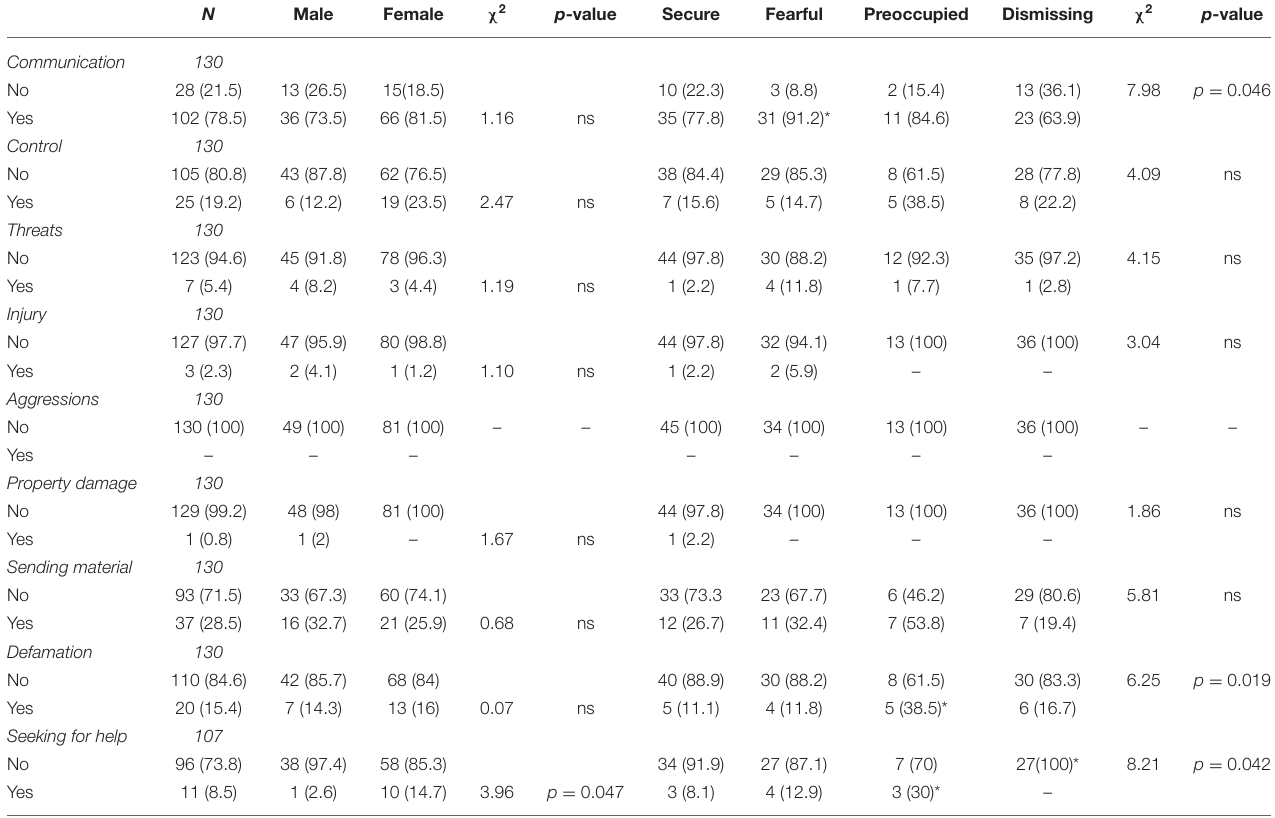
TABLE 3 | Cross-tabulation of gender and state of mind and dysfunctional behaviors. N Male Female χ 2 p -value Secure Fearful Preoccupied Dismissing χ 2 p -value